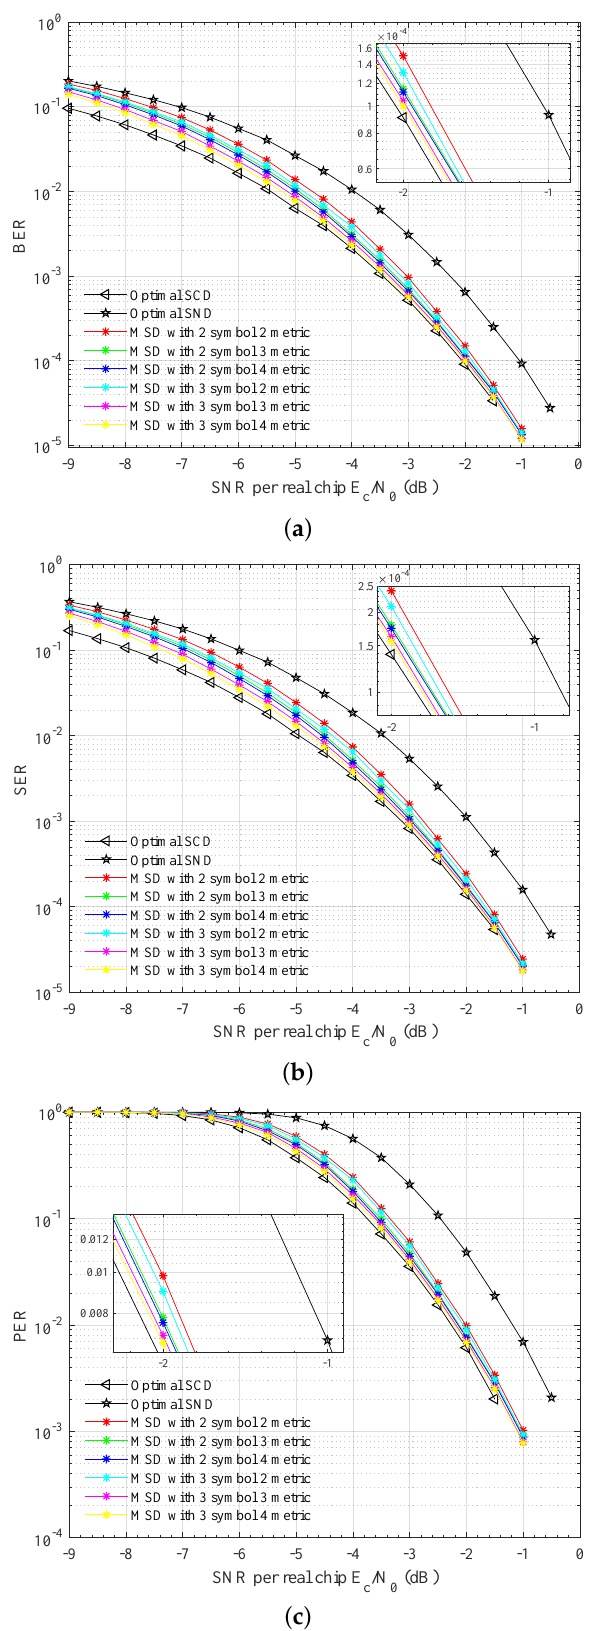
Figure 3. Detection performance impact of factor p under the proposed MSD scheme over a pure additive white Gaussian noise (AWGN) channel. ( a ) bit error rate (BER) performance; ( b ) symbol error rate (SER) performance; ( c ) packet error rate (PER)